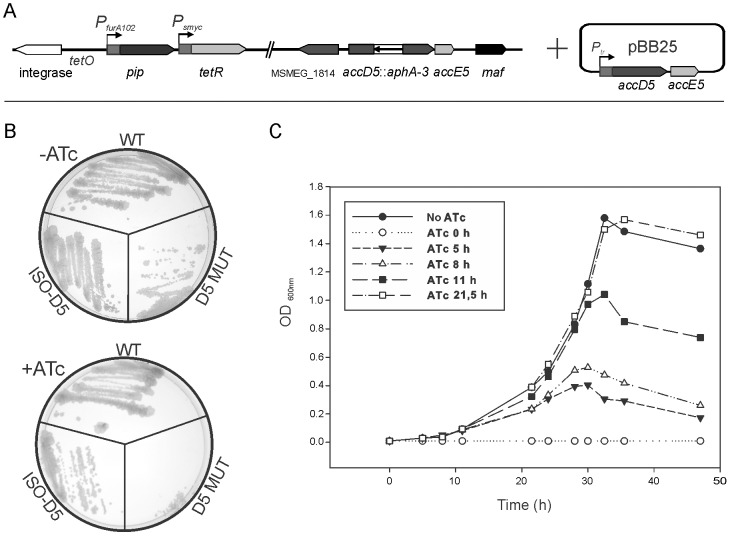

accD5-accE5 conditional mutant D5 MUT.A) Schematic representation of the genetic organization of the M. smegmatis conditional mutant D5 MUT. In pBB25, transcription of the accD5-accE5 operon is controlled by Ptr, which can be repressed with the addition of ATc to the media. B) M. smegmatis mc2155 (WT), Isogenic (ISO-D5) and D5 MUT strains were grown on plates with 200 ng ml−1 (+ATc) or without ATc (−ATc). C) Growth curves of D5 MUT in the presence or absence of ATc 200 ng ml−1. A saturated culture of D5 MUT grown at 37°C was diluted in fresh 7H9 medium to an OD600 nm of 0.01 and further incubated at 37°C. After 5, 8, 11 and 21 h; an aliquot of the main culture was separated and supplemented with ATc 200 ng ml−1. Growth was followed by measuring OD600 nm.